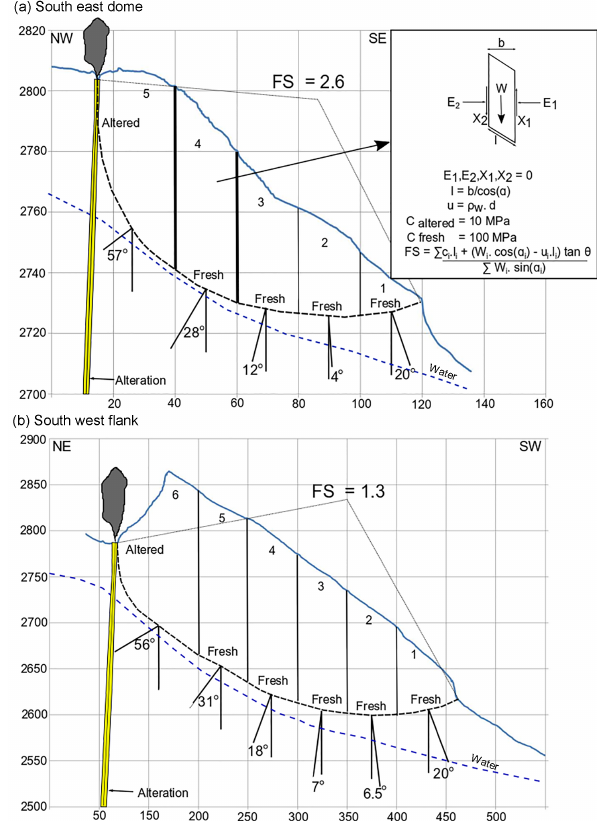
Figure 9. Conceptual model of slope stability shows the geometry of (a) the southern Merapi dome sector and (b) the southwestern Merapi flank. The hydrothermal alteration along the fracture, the estimation of ground water and the heterogeneity of the rock cohe- sion are also indicated. Our calculation of factor of safety by using the Fellenius method shows that the southern dome is relatively sta- ble (FS = 2.6), while the southwestern Merapi flank is approaching a warning (FS = 1.3) and requires further monitoring and assess-